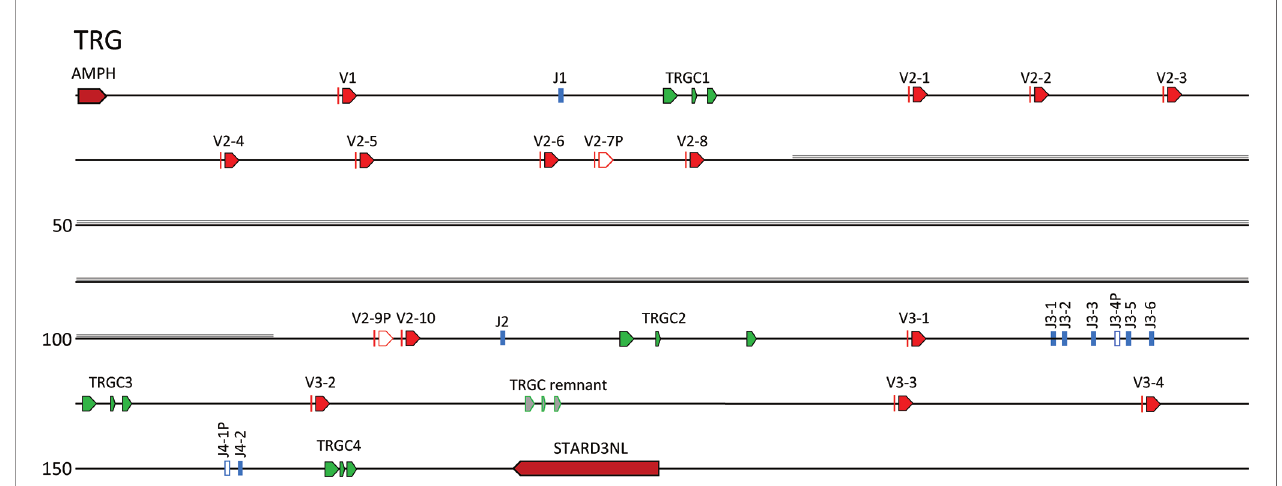
FIGURE 5 | The channel cat fi sh TRG locus. Schematic representation of the channel cat fi sh TRG locus. Red arrows mark the location and direction of transcription for each of the TRGV genes and green arrows mark the location of the TRGC1, TRGC2, TRGC3 and TRGC4 genes. The TRGJ genes are in blue and pseudogenes are in white. The region of repeats is shaded in gray. The two genes that fl ank the locus, Amphiphysin ( AMPH ) and STARD3 N-terminal like ( STARD3NL ) are